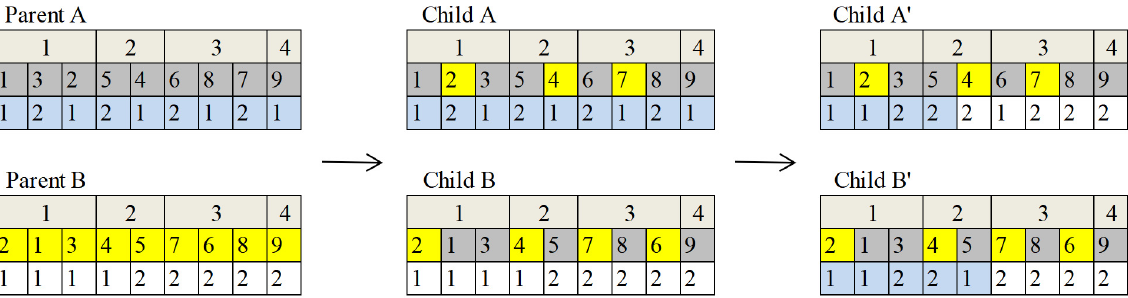
Figure 2. Schematic diagram of crossover operation.